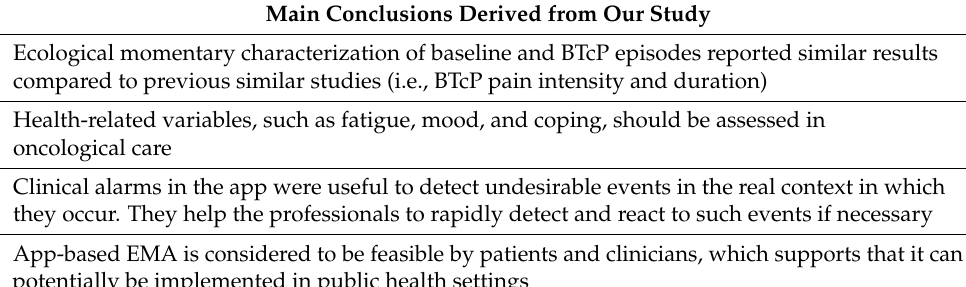
Table 4. Summary of the discussion